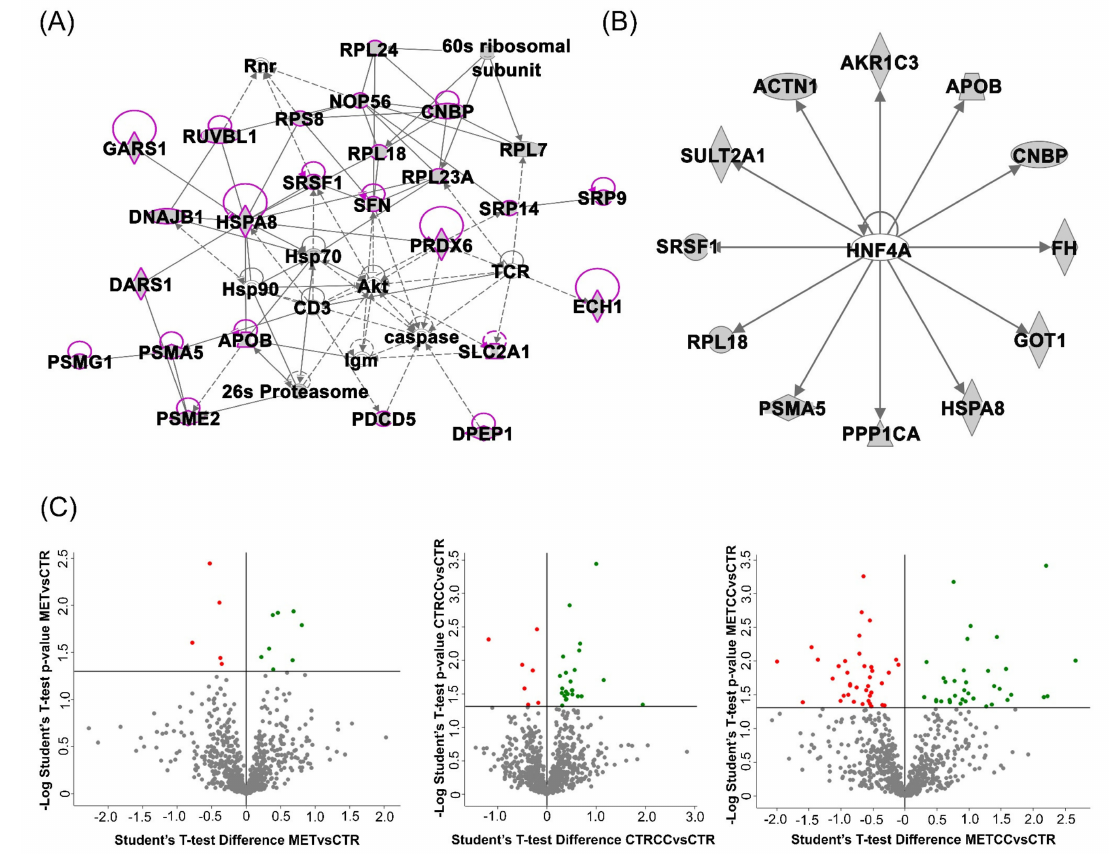
Figure 1. Bioinformatic analysis of the proteomic data of HepG2 cells grown for 48 h (CTR), in the presence of Compound C (CTRCC), high methionine (MET) and high methionine and Compound C (METCC). ( A ) Ingenuity ® Pathway Analysis (IPA) analysis carried out on the 46 proteins common to all data sets, whose expression is statistically di ff erent, highlighted that 25 out of 46 proteins di ff erentially expressed belong to a network classified as: cancer, protein synthesis, RNA damage and repair. These proteins are shown in magenta among all the proteins belonging to the pathway. Each protein is reported with the corresponding IPA symbol. ( B ) The upstream regulator analysis, based on prior knowledge of expected e ff ects between transcriptional regulators and their target genes in IPA, shows hepatocyte nuclear factor 4 (HNF4A) ( p -value 0.001) which target 12 / 46 of the proteins di ff erentially expressed. ( C ) Volcano plots of the comparison MET versus CTR, METCC versus MET, CTRCC versus CTR. In green: proteins upregulated; in red: proteins downregulated; in grey: proteins that are not statistically di ff erent (Student’s t -test p -value =